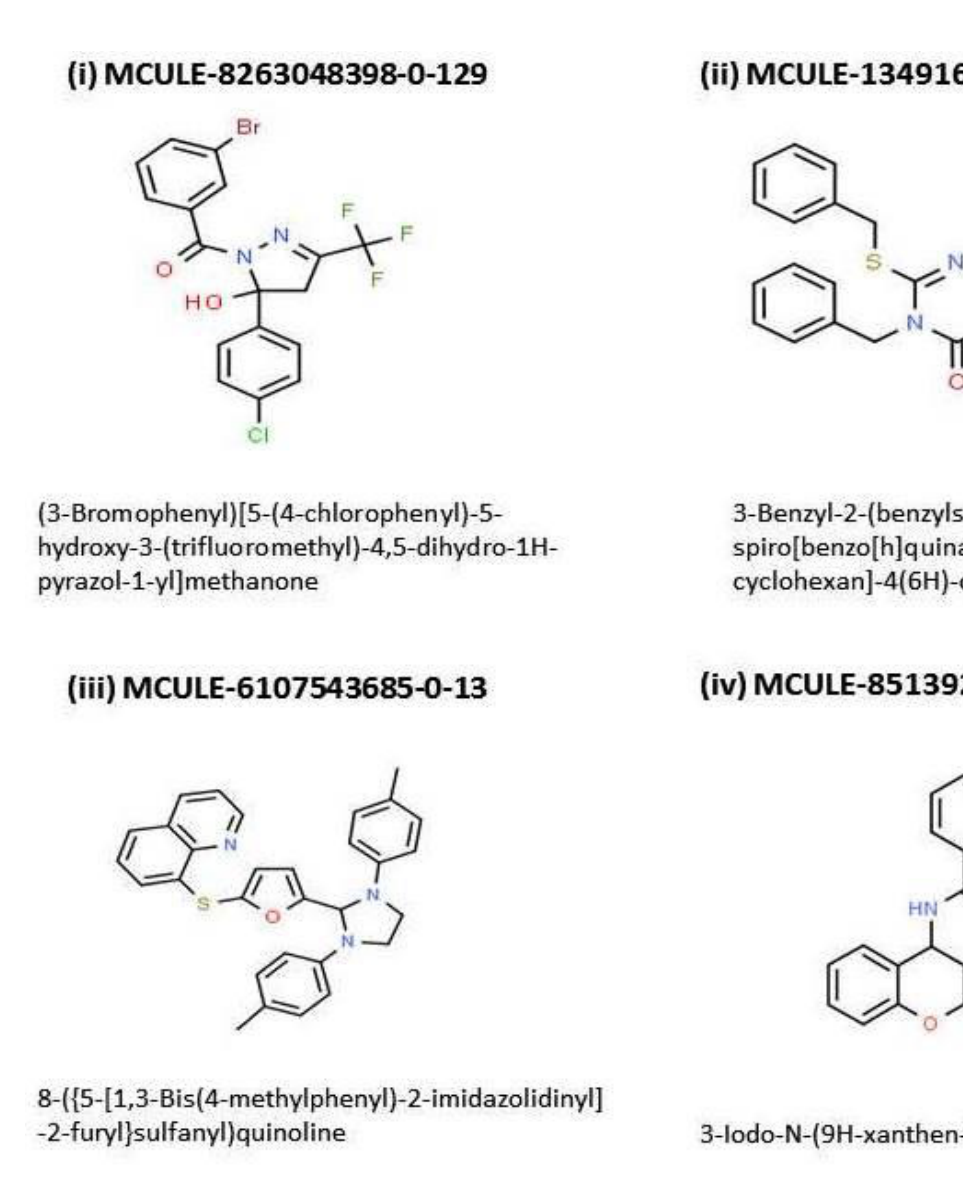
Figure 2: Molecular structures of the 4 top ranking ligands obtained from the screening cascade The binding contact residues are